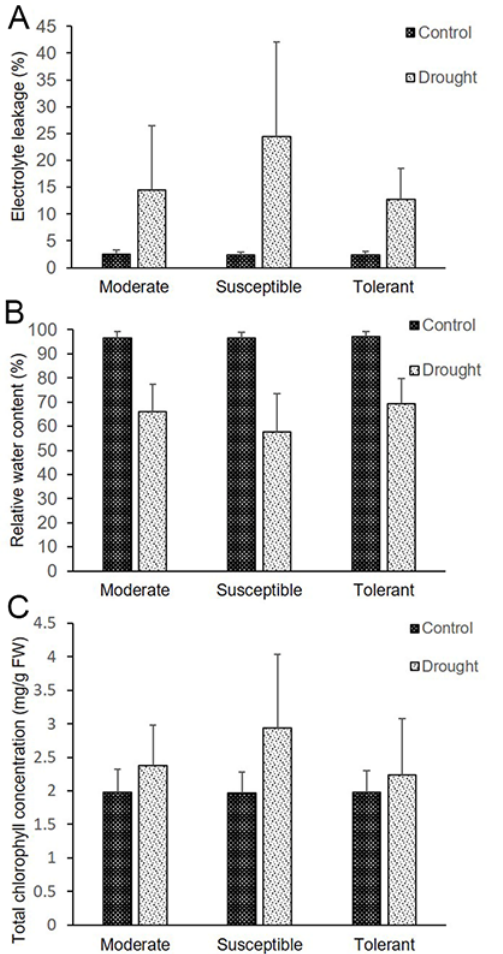
Figure 1 Comparisons of the means of physiological traits, i.e., electrolyte leakage ( A ), relative water content ( B ), and total chlorophyll concentration ( C ) of 80 rice cultivars divided into three groups: susceptible, moderately tolerant, and